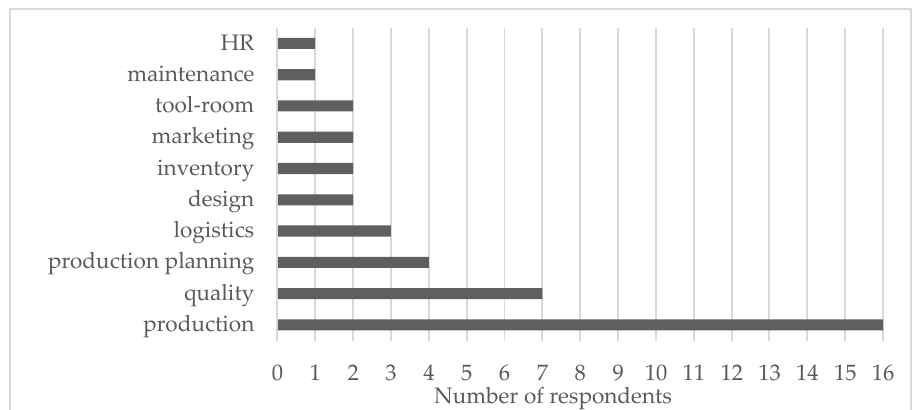
Figure 1. Sample structure.